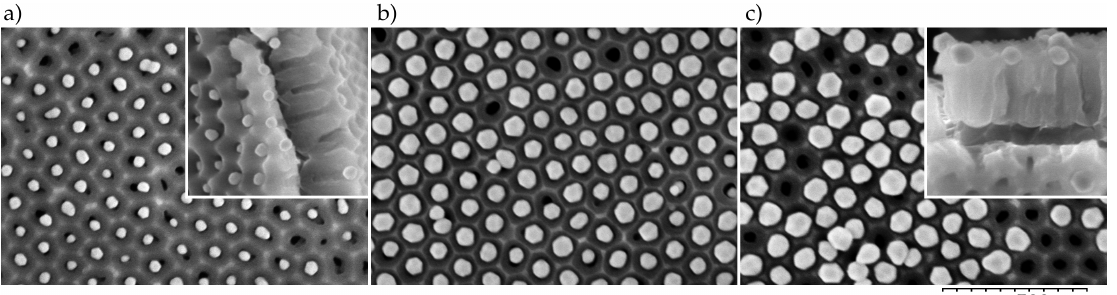
Figure 2. Top view SEM images of ( a ) 40 nm, ( b ) 60 nm, and ( c ) 80 nm Au nanoparticles on an oxalic acid electrolyte NAA surface. Insets show the sample